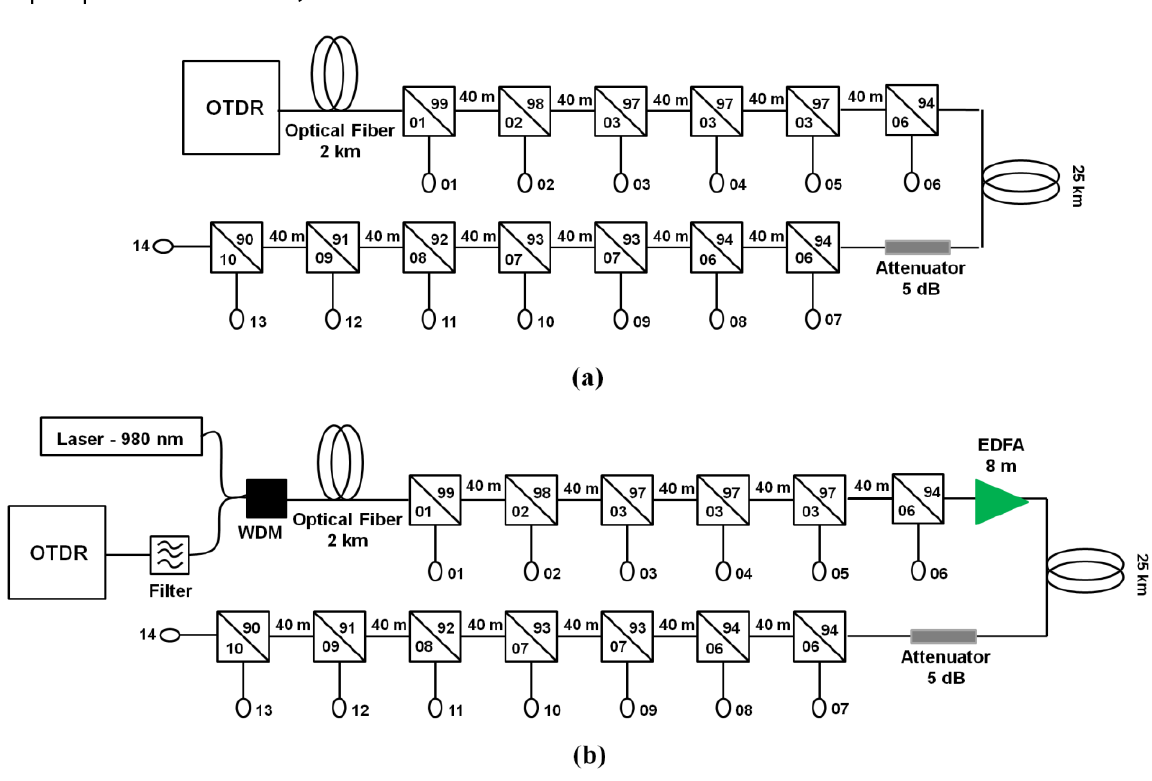
Figure 1. Multipoint sensor system ( a ) without and ( b ) with amplification